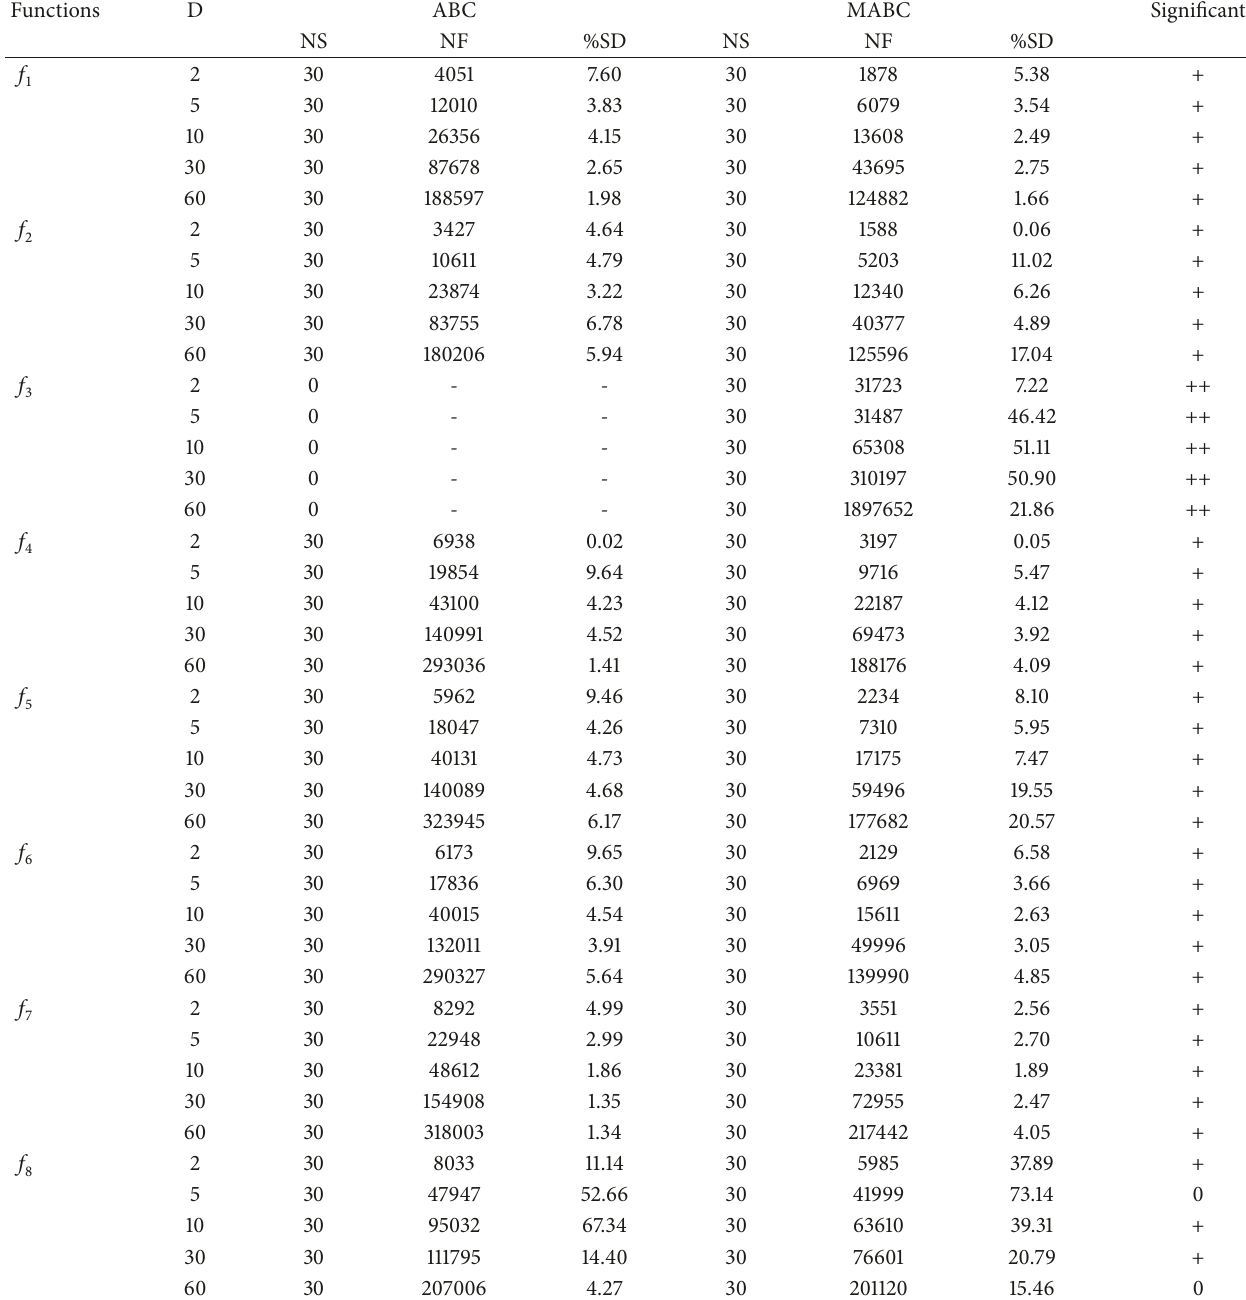
Table 4: Performance comparison of ABC and MABC algorithms using NS, NF, and %SD values and 𝑉𝑇𝑅 = 10 −10 . Functions